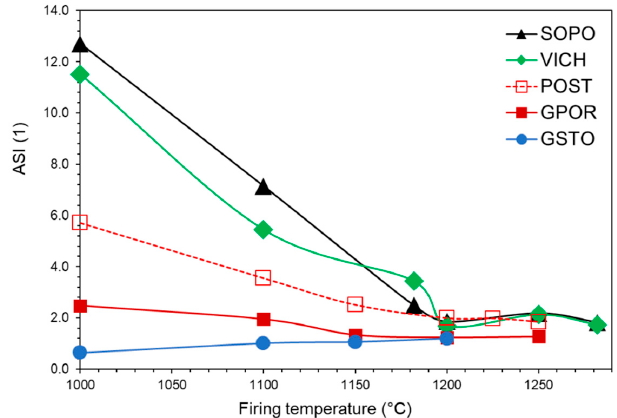
Figure 11. Alumina saturation index (ASI) vs firing